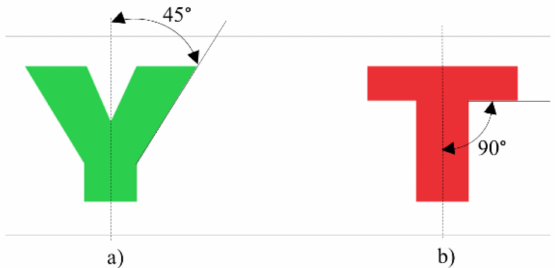
Figure 4. Overhang angle: ( a ) does not need support structures; ( b ) needs support structure.